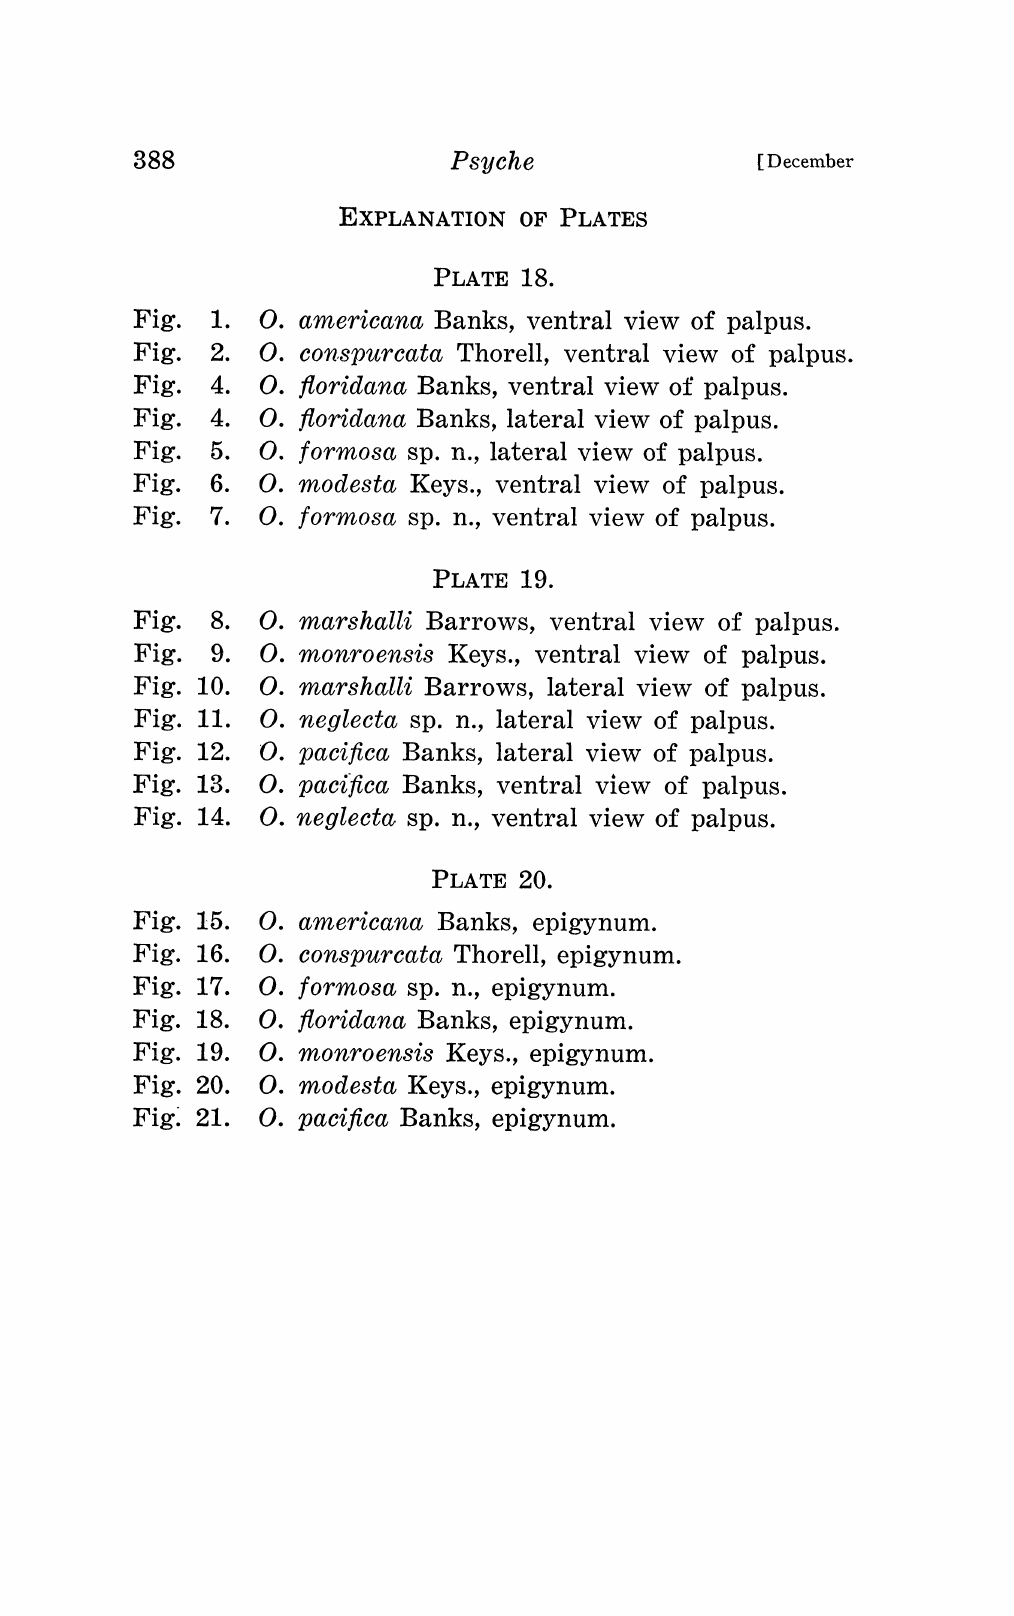
Fig. 1. O. americana Banks, ventral view of palpus. Fig. 2. O. conspurcata Thorell, ventral view of palpus. Fig. 4. O. floridana Banks, ventral view of palpus. Fig. 4. O. floridana Banks, lateral view of palpus. Fig. 5. O. formosa sp. n., lateral view of palpus. Fig. 6. O. modesta Keys., ventral view of palpus. Fig. 7. O. formosa sp. n., ventral viev of palpus. PLATE 19. Fig. 8. O. marshalli Barrows, ventral view of palpus. Fig. 9. O. monroensis Keys., ventral view of palpus. Fig. 10. O. marshalli Barrows, lateral view of palpus. Fig. 11. O. neglecta sp. n., lateral view of palpus. Fig. 12. O. pacifica Banks, lateral view of palpus. Fig. 13. O. pacifica Banks, ventral view of palpus. Fig. 14. O. neglects sp. n., ventral view of palpus. PLATE 20. Fig. 15. O. americana Banks, epigynum. Fig. 16. O. conspurcata Thorell, epigynum. Fig. 17. O. formosa sp. n., epigynum. Fig. 18. O. floridana Banks, epigynum. Fig. 19. O. monroensis Keys., epigynum. Fig. 20. O. modesta Keys., epigynum. Fig: 21. O. pacifica Banks,